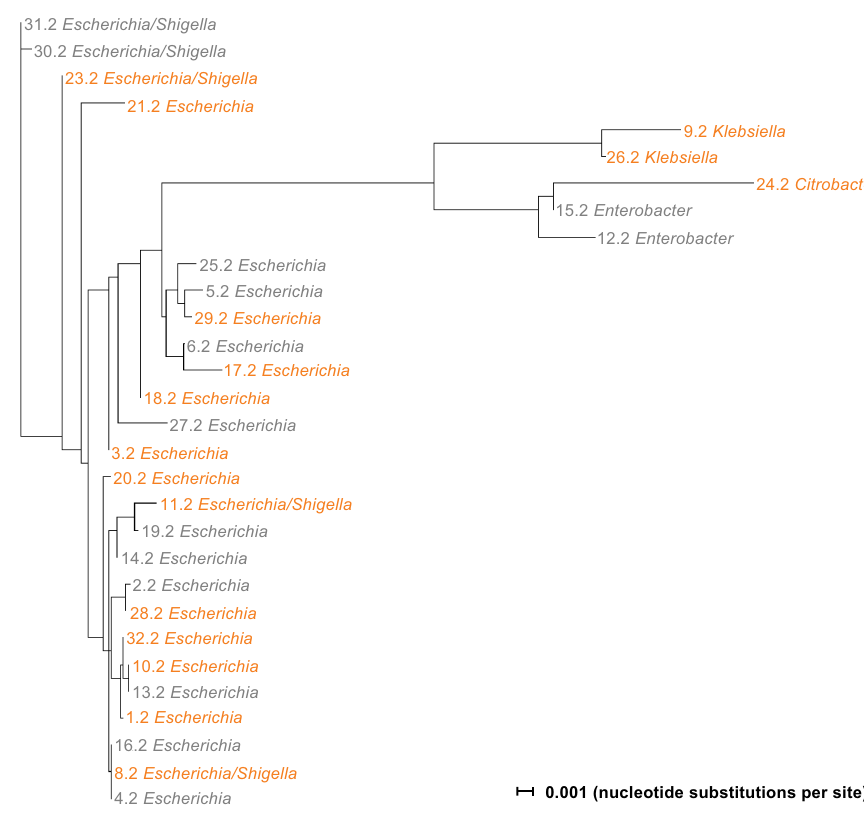
Fig 6. Phylogenetic tree of Enterobacteriaceae strains isolated one day after treatment. Tree showing the relatedness between bacterial strains (n = 30) isolated from participant samples one day after treatment with sucrose (grey) or lactulose (orange). 16S rRNA sequences were annotated by BLAST and aligned using MUSCLE and SplitsTree. Escherichia/Shigella thereby indicates a strain with a sequence compatible with both, E . coli and Shigella . Horizontal lines indicate nucleotide substitutions per site. Please note that E . coli and Shigella are extremely closely related. Thus, the detection of Escherichia/Shigella -like sequences does not imply that Shigella spp. were present in the stools of any of the